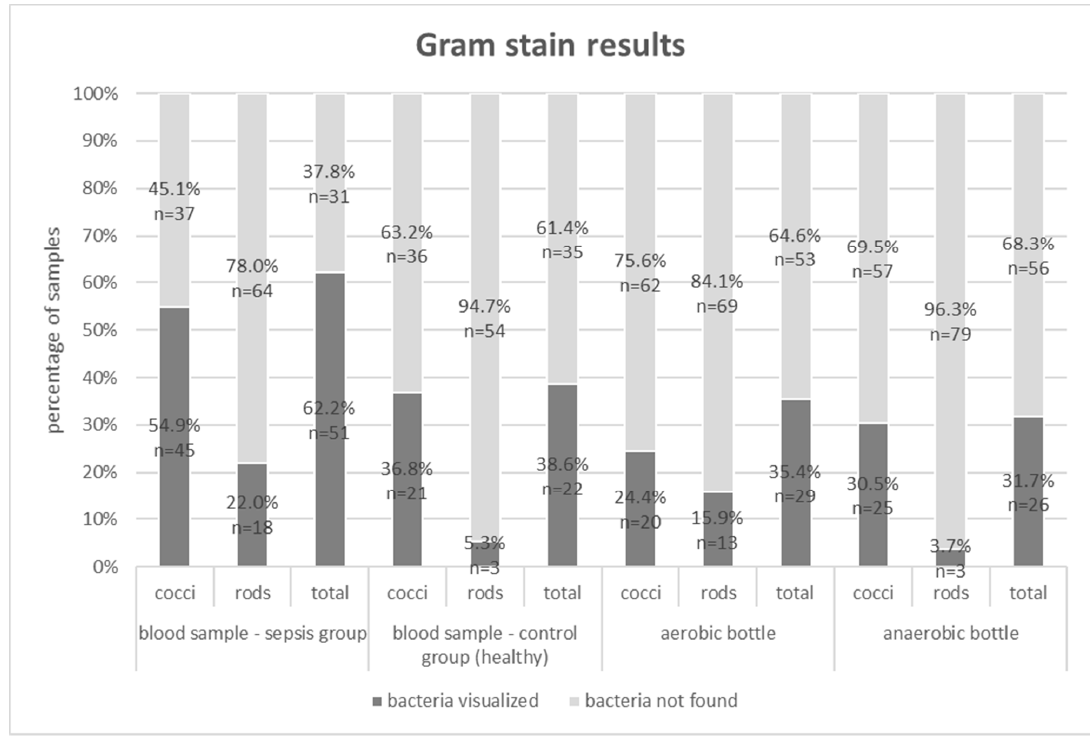
Figure 1. Gram stain results for blood samples, aerobic and anaerobic bottles in the group of patients with sepsis and for blood samples in the control group; ( n )—absolute values of visualized bacteria.